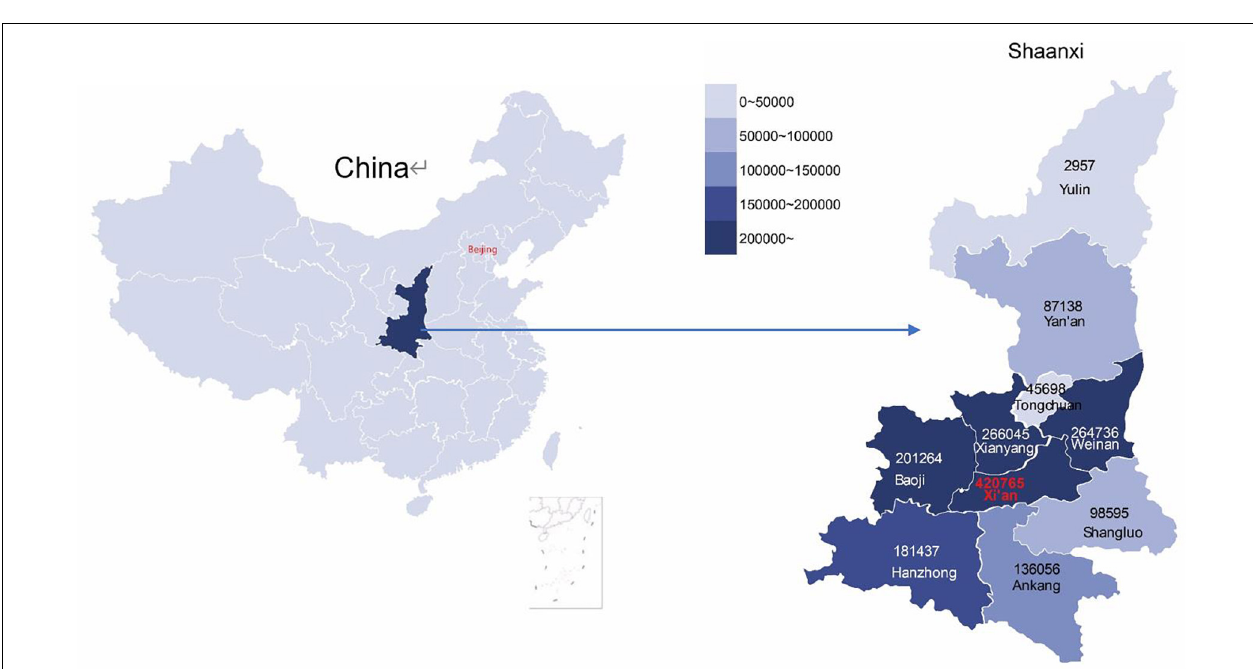
FIGURE 1 | Flowchart demonstrates the steps of cohort construction. The inclusion criteria of cohort participants, (1) blood donors are recorded in both Shaanxi Blood Donor’s Database and Shaanxi resident’s Electronic Health Records; (2) blood donors have a unique identification number to enable them to be linked across datasets; (3) each non-blood donor is matched to a blood donor with identical age, gender and location of residence.